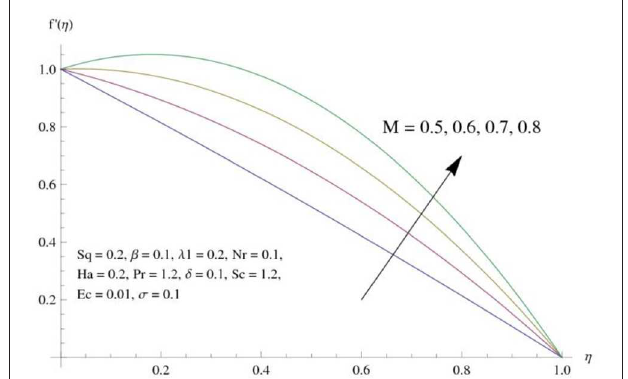
FIGURE 6 | Behavior of M on f ′ ( η ).